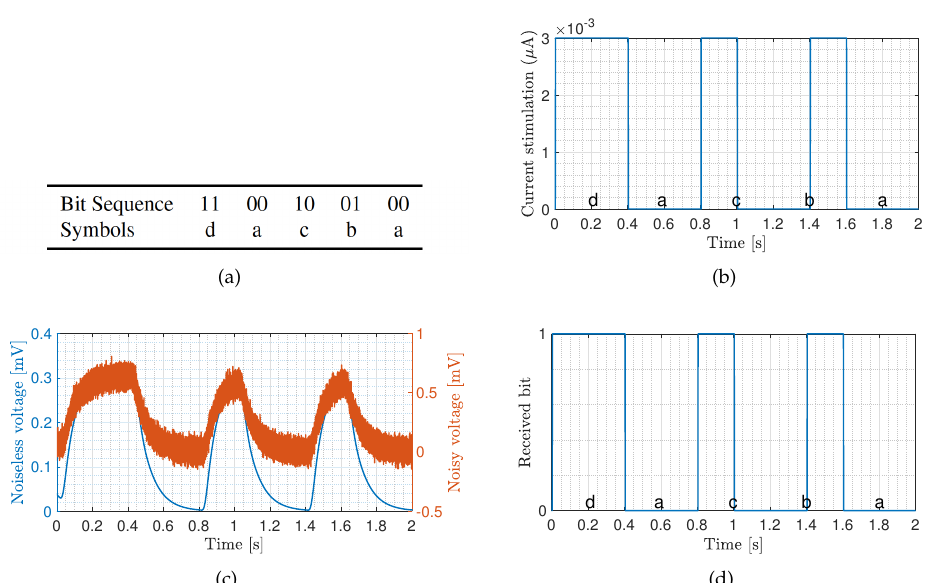
Figure 8. Transmission of bit sequence over ten cardiomyocytes with stimulation signal amplitude of 3 nA. The transmission bin of 2 seconds has been selected to demonstrate the system performance. ( a ) Sample bit sequence and associated symbols. ( b ) Transmitted signal. ( c ) Received signal. ( d ) Decoded signal.